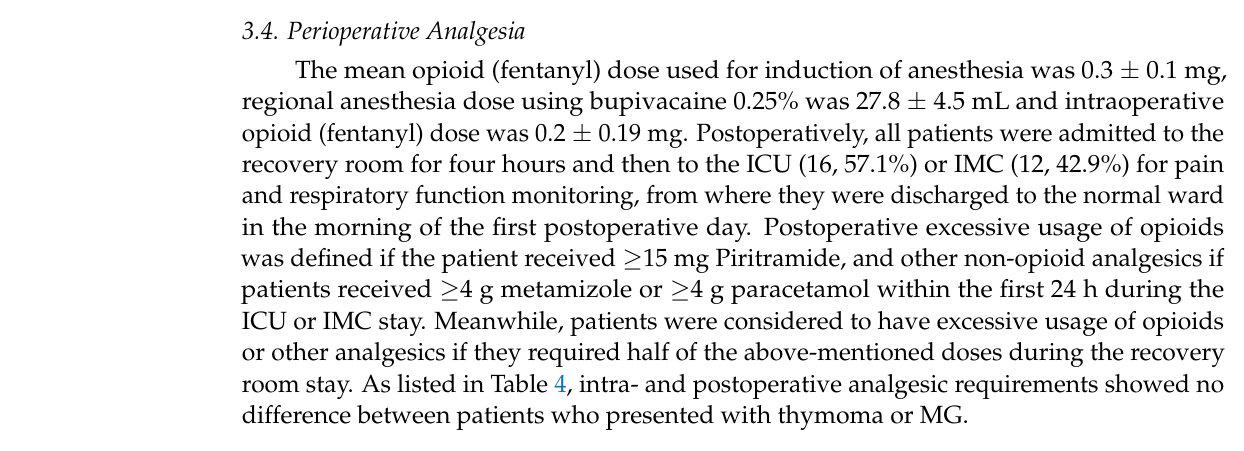
Table 4. Perioperative analgesic